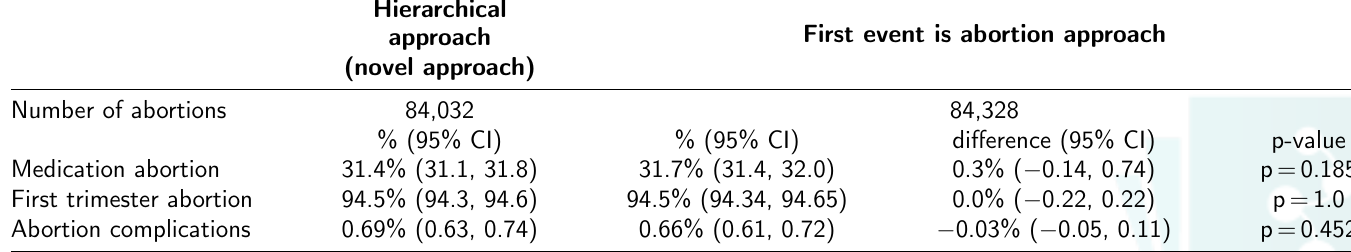
Table 4: Impact of using hierarchical vs. first event is abortion approach (Principle 4) to define abortion date when creating abortion cohorts on the number and characteristics of abortions